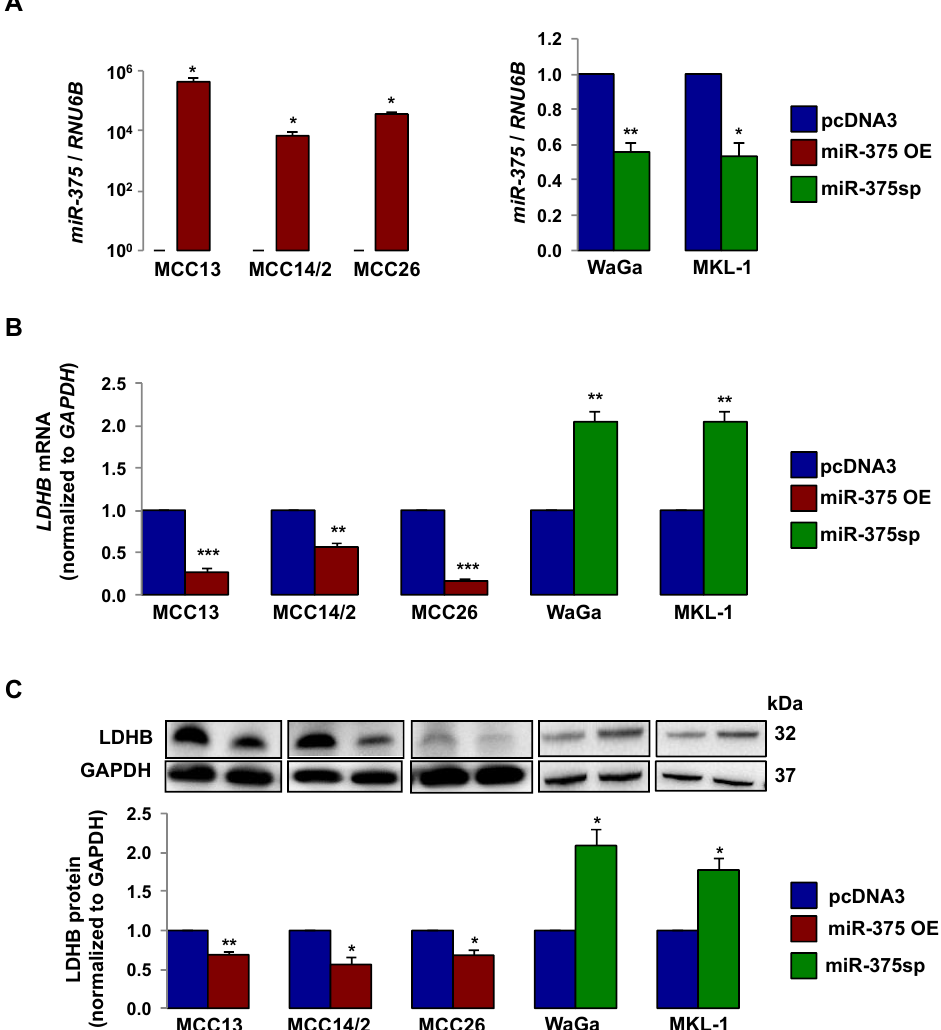
Figure 2. miR-375 regulates LDHB mRNA and protein levels. ( A ) RT-qPCR analysis of miR-375 levels in MCPyV − MCC cell lines (MCC13, MCC14/2, and MCC26) transfected with miR-375 expression plasmid (miR-375 OE) or vector control (pcDNA3) after 48 h of transfection and in MCPyV+ MCC cell lines (WaGa and MKL-1) transfected with miR-375 sponge (miR-375sp) or vector control (pcDNA3) after 72 h of transfection. The relative expression of miR-375 was normalized to RNU6B . ( B ) Quantification of LDHB mRNA expressions in cells with over-expression or inhibition of miR-375 in MCC cell lines by RT-qPCR. LDHB levels were normalized to GAPDH mRNA. ( C ) Western blot analysis of LDHB protein levels in cells with over-expression or inhibition of miR-375 . Representative Western blot images are shown in the upper panel, and the quantifications of LDHB levels are presented in the graph below. Error bars represent SEM (n = 3). * p < 0.05, ** p < 0.01, and *** p < 0.001 by paired Student’s t -test.